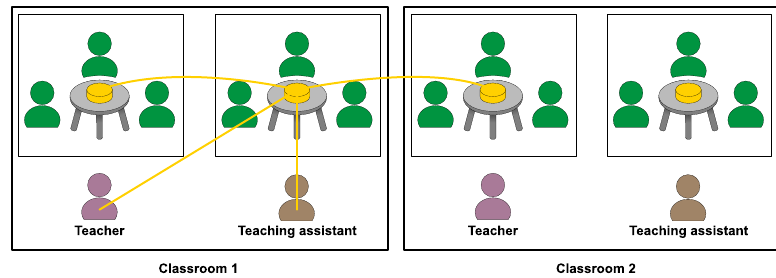
Figure 2. User context of developed orchestration tools in our paper.